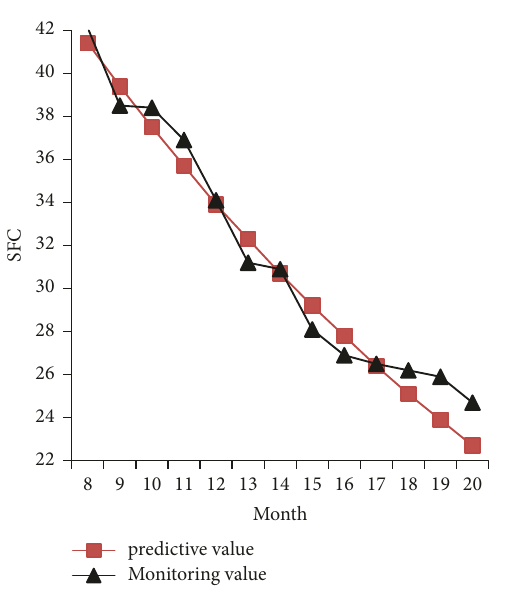
Figure 7: The change curves of